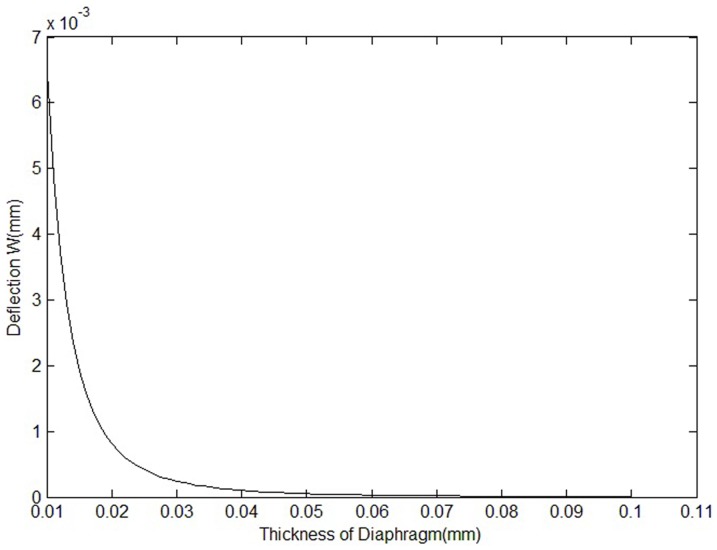
Correlation of maximum deflection and thickness of the diaphragm.